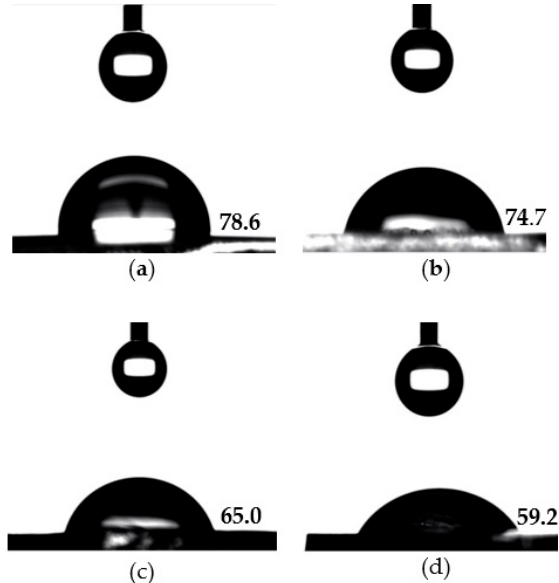
Figure 2. Contact angles of nanopure water droplets (4.5 µ L) on ( a ) pristine p(HEMA) hydrogel; ( b ) p(HEMA)/p(MPC)0.1 hydrogel; ( c ) p(HEMA)/p(MPC)0.25 hydrogel; and ( d ) (HEMA)/p(MPC)0.5 hydrogel.